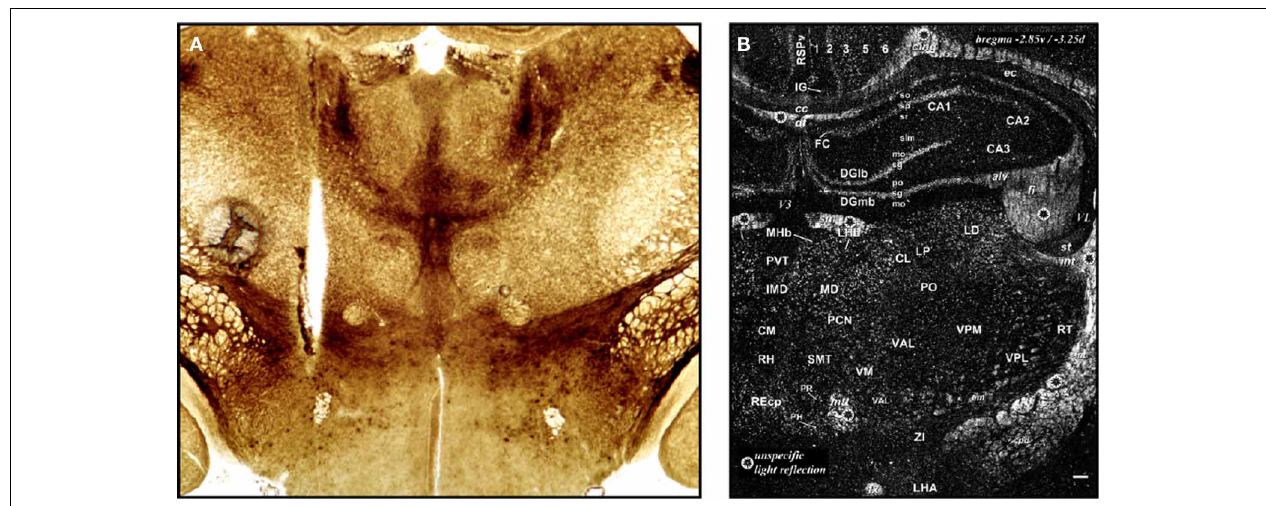
FIGURE 7 | True vs. inferred stereotaxic space. In (A) , which is a coronal section from a plate in Paxinos and Watson (1986), an example of tissue visualized using true stereotaxic space is shown. The needle track marks the location of a needle traversing the section through its cut plane while the subject was placed in a stereotaxic frame. (B) In